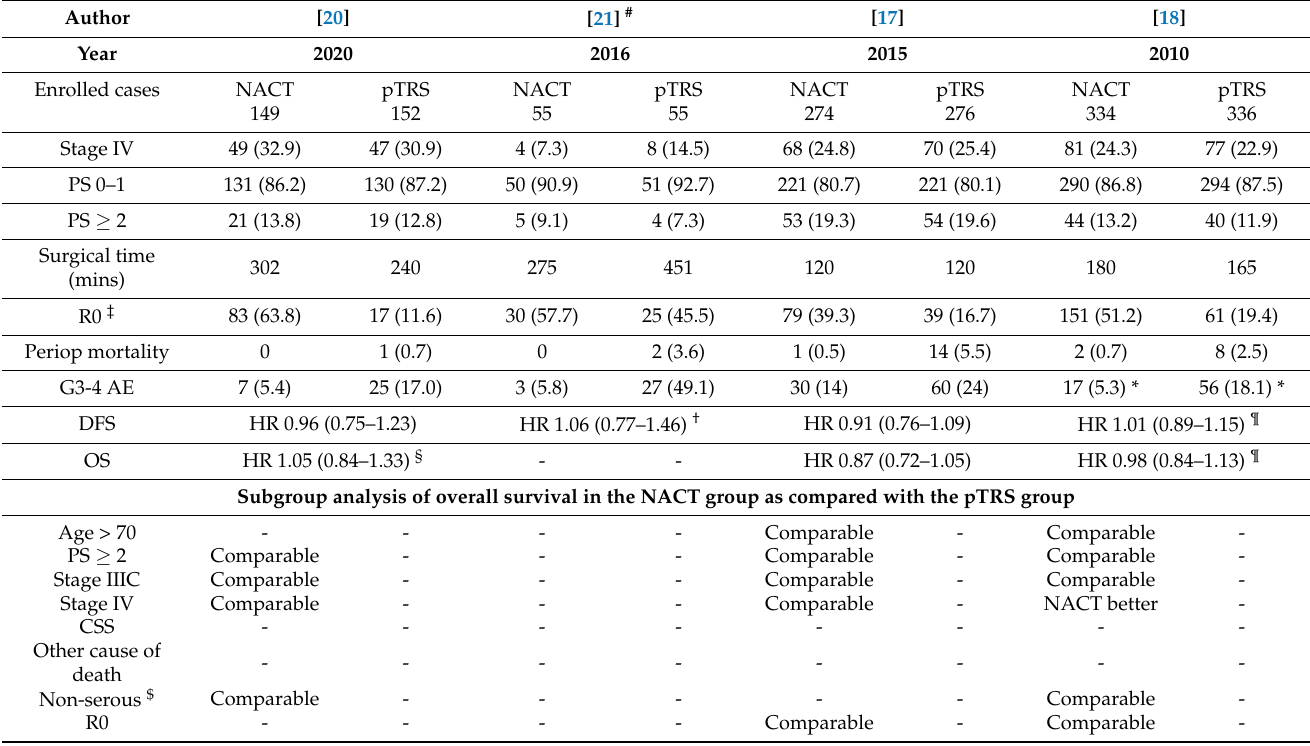
Table 1. Summary of RCTs comparing NACT to pTRS in advanced epithelial ovarian